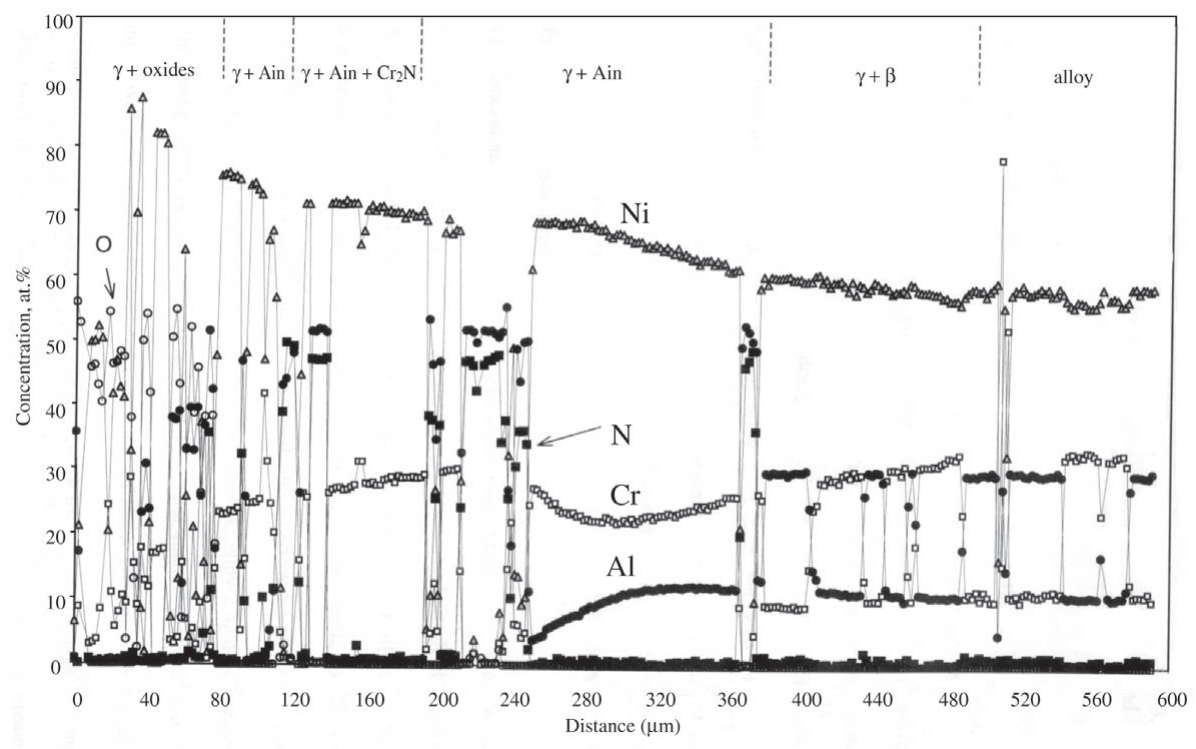
Figure 6. Microprobe analysis within subsurface zone of Alloy 5 after 260 cycles of reaction.